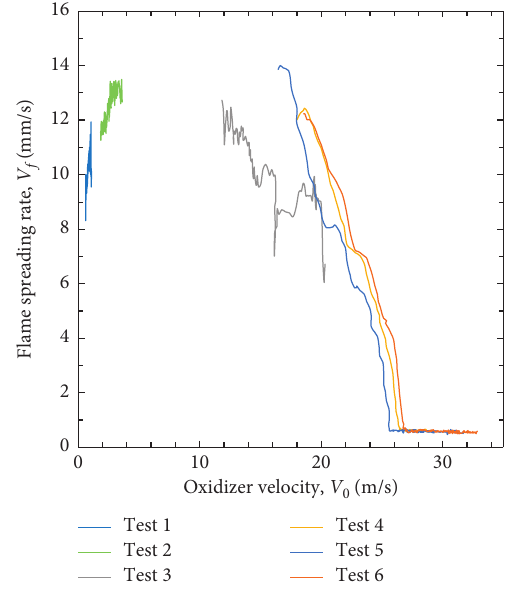
Figure 6: Flame spreading rate vs. oxidizer flow rate.